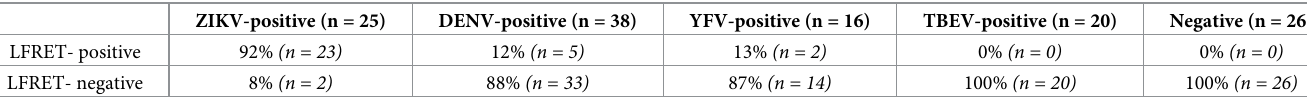
Table 2. Class-independent LFRET test outcomes in different sample